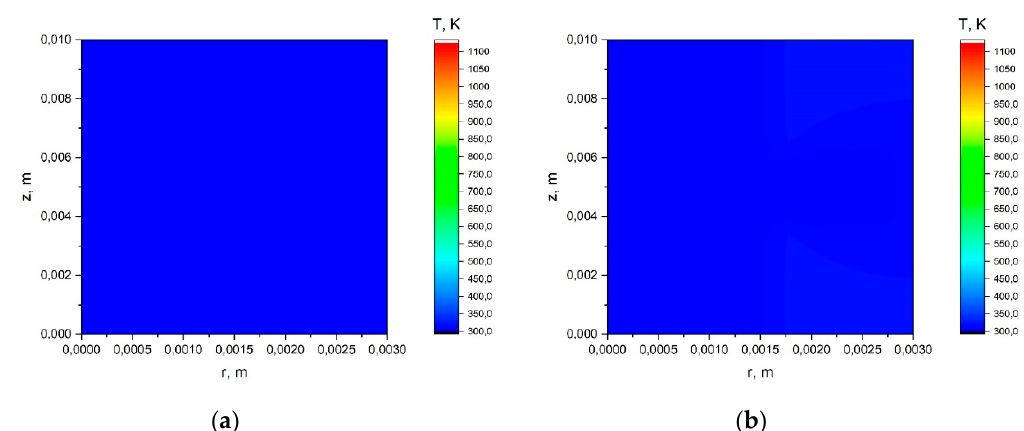
Figure A24. Temperature distribution in the stem of a herbaceous plant: R = 0.003 m, t = 0.5 s, q = 0.5 kW/m 2 ( a ); R = 0.003 m, t = 0.5 s, q = 3 kW/m 2 ( b ).